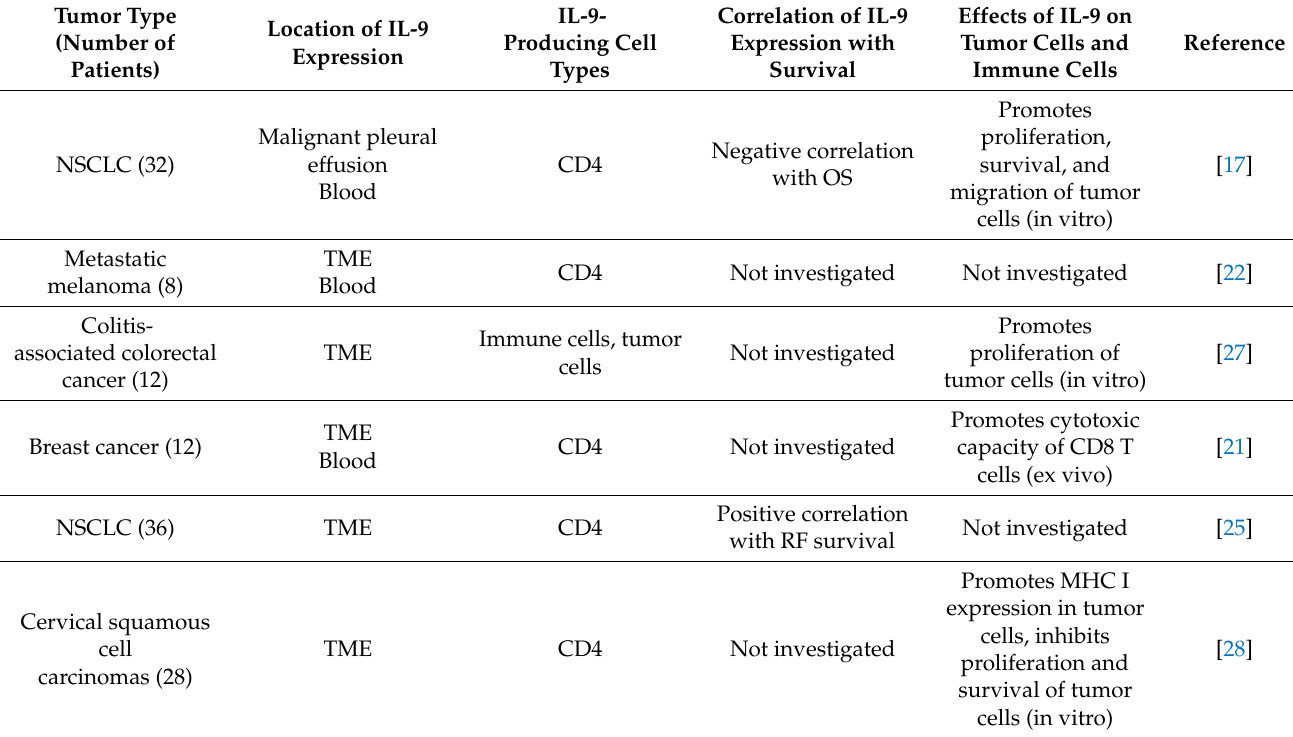
Table 1. The role of IL-9 in human solid